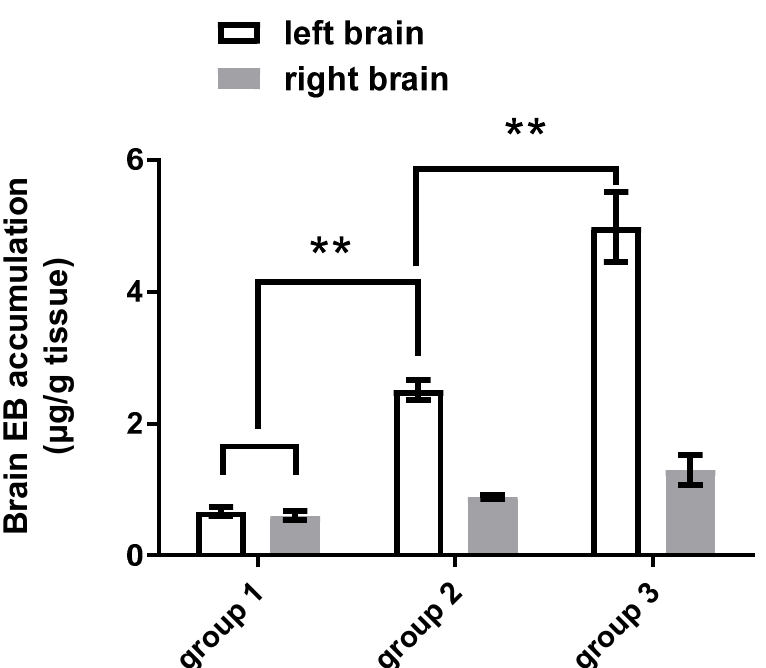
Figure 6. Comparison of BBBD induced by one-spot and two-spot sonication. Brain EBD accumula- tion of two-spot sonication-treated mice increased 74.8% compared to that of one-spot sonication- treated mice. Brain EBD accumulation on the ultrasound-treated side was 2.80-fold and 3.87-fold that of the untreated side after one-spot and two-spot sonication treatment, respectively; ** indicates p < 0.0001.